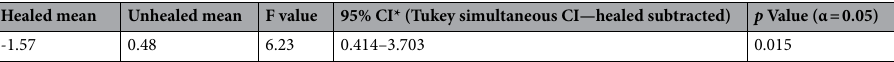
Table 4. Analysis of variance (ANOVA) to test relationship between rate of change in textural features in week 2 with respect to the baseline (i.e. week 0) when transformed in PCA domain (week2/ week0). * CI: Confidence interval.